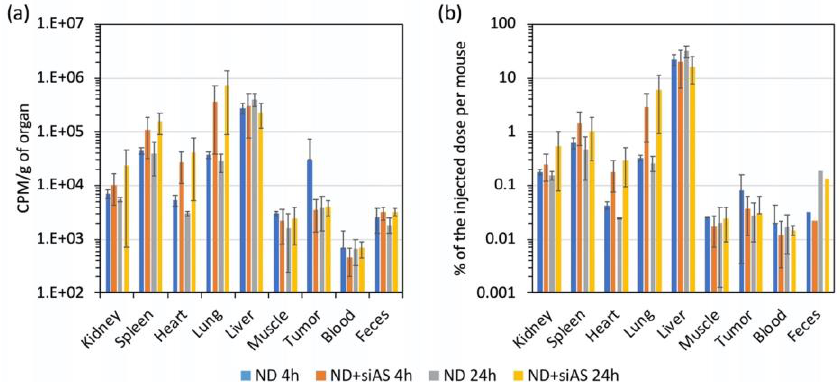
Figure 5. Mouse organ distribution of uncomplexed T-DND or complexed with siRNA at mass ratio 5:1 of T-DND:siRNA. The total radioactivity of each tissue is measured after 4 h and 24 h for 3 animals per series. Error bars: standard deviations. ( a ) Radioactivity presented as count per minutes (cpm) per gram of tissue or feces. The latter corresponds only to the fraction collected in the rectum of each animal. ( b ) Radioactivity from each full organ, presented as the percentage of the total injected dose. Feces were collected for all the animals simultaneously in the same metabolism cage, but the total amount, including non-expelled feces is not known which is why we could not include feces data in B. ND + siAS: DND complexed with siRNA sequence antisense for EWS-FLI1 oncogene. The differences between error bars for the different conditions are due to (i) the variability between animal groups, and (ii) to the fact that the T-DND quantifications were done only on portions of ≈ 100 mg of each organ, and that we cannot exclude an inhomogeneous distribution of T-DND within the